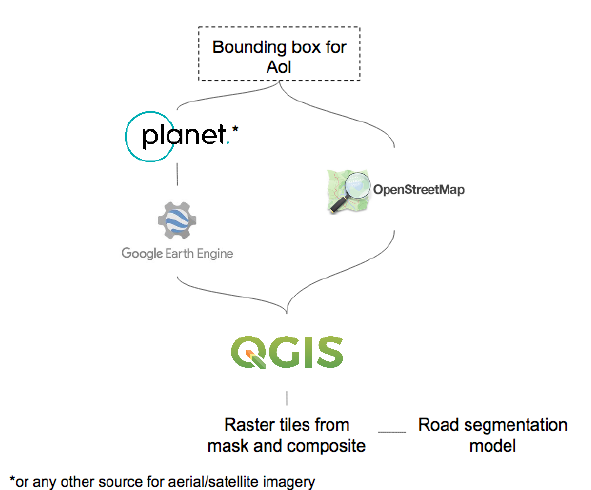
Figure 6. Schema for the pipeline areas of interest considered with the 3 composites used and 3 more for checking both seasons, the resulting images are in the order of thousands; even if the annotations are not too precise, the volume produced enables training a ML model. For further research, it is proposed to work in cooperation with mapping teams like YouthMappers 4 to verify the width of the roads and type of the roads for the considered area of interest to increase the accuracy of the output training